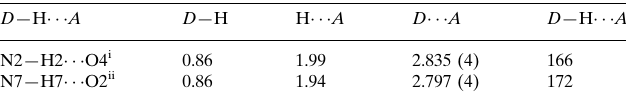
Hydrogen-bond geometry (A˚ , (cid:2)